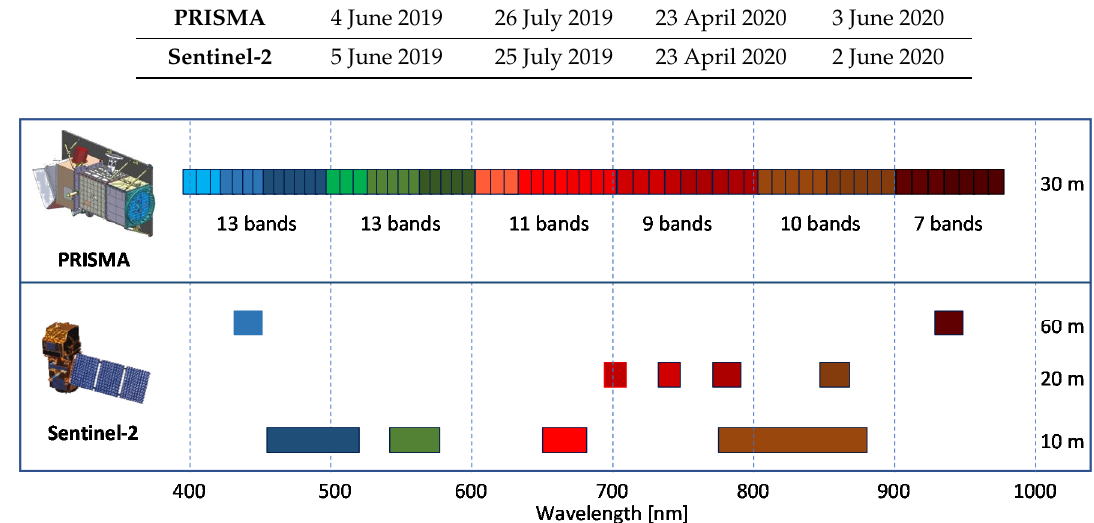
Figure 2. Thematic representation of the PRISMA and Sentinel-2 spectral bands and spatial resolutions.